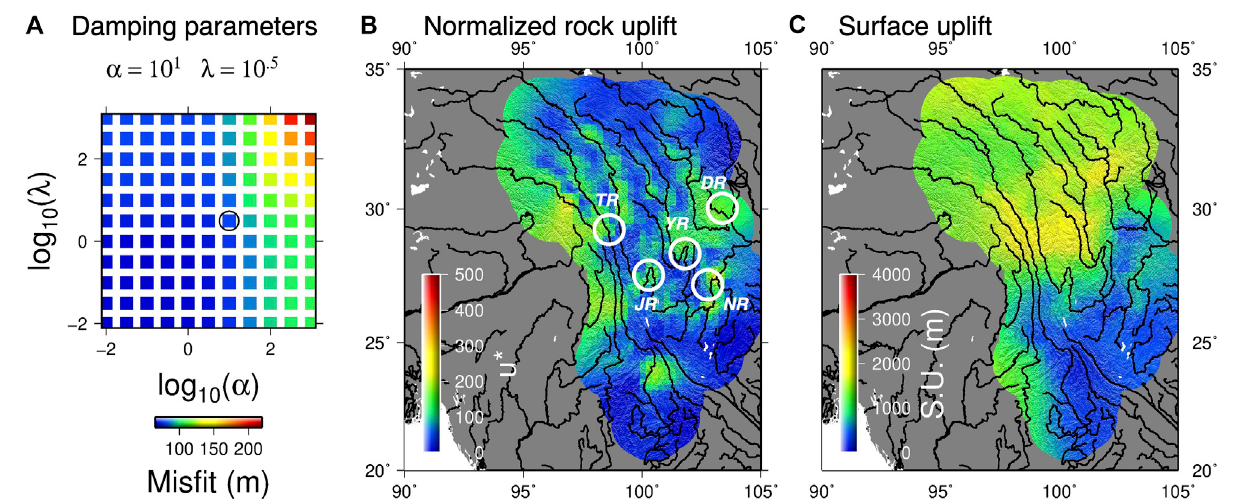
FIGURE5 | Predicted normalized rock uplift ratesand spatially variable surface uplift. (A) A two-dimensionalL-surface showing the trade-off between model mis fi t and the two damping parameters which control the roughness of the normalized rock uplift ( α ) and the surface uplift map ( λ ). However, each damping parameters in fl uences both maps as the u* and S.U. both predict the topography and control the mis fi t between the observed and predicted topography, which isminimized by the inversion.Amodel ispreferredthat hasasmall mis fi tvalue,but also results insmoothmaps. Thismodel isshown bythecirclein (A) and the maps arepresented in (B) and (C) .Thesensitivity oftheinversion tothedampingparametersispresented in SupplementaryMovieS1 .Low u* valuesareobservedwherelow-reliefsurfaces are found but higher values are observed along the trunk streams and the con fl uence of the Jinsha river with the Niulan River (NR) and aspects of the drainage network, suchaslargeparallelriversintheThreeRiversarea(TR)andthelargebendsintheJinshaRiver(JR),andtheYalongRiver(YR).Highvaluesarealsoobservedclosetothe Dadu River (DR) which is related to the steep Longmen Shan. These anomalies are more apparent in the rougher models.